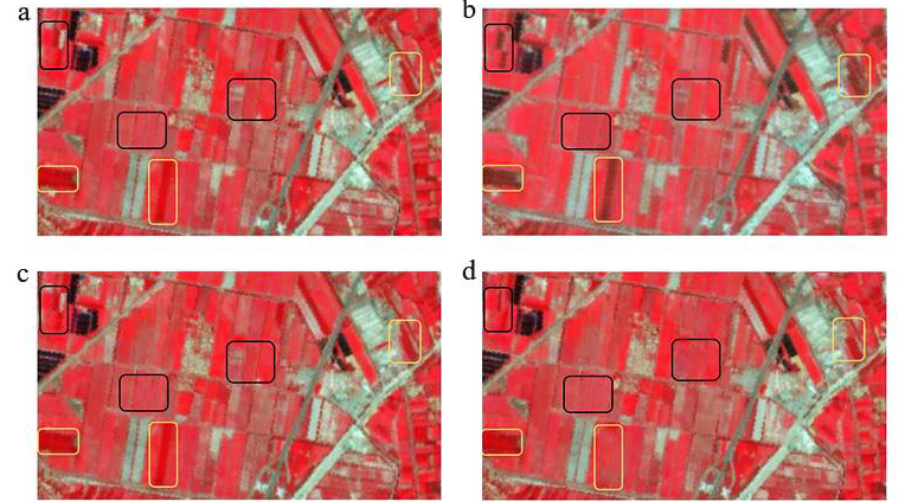
Figure 7. The local area comparison of the predicted images and the real images. ( a ) shows the real image on 12 June, ( b ) shows the real image on 10 July, ( c ) shows the predicted image of Expt.1 on 10 July, and ( d ) shows the predicted image of Expt.2 on 10 July.